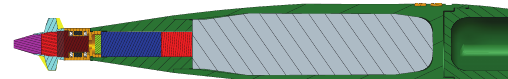
Figure 3: A class of spin-stabilized projectile with fixed canards.